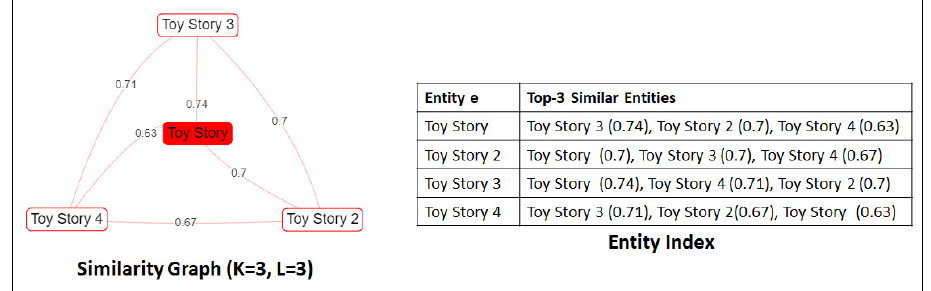
Figure 7. The resulting Similarity Graph for “Toy Story” Movie with parameters K = 3 and L =